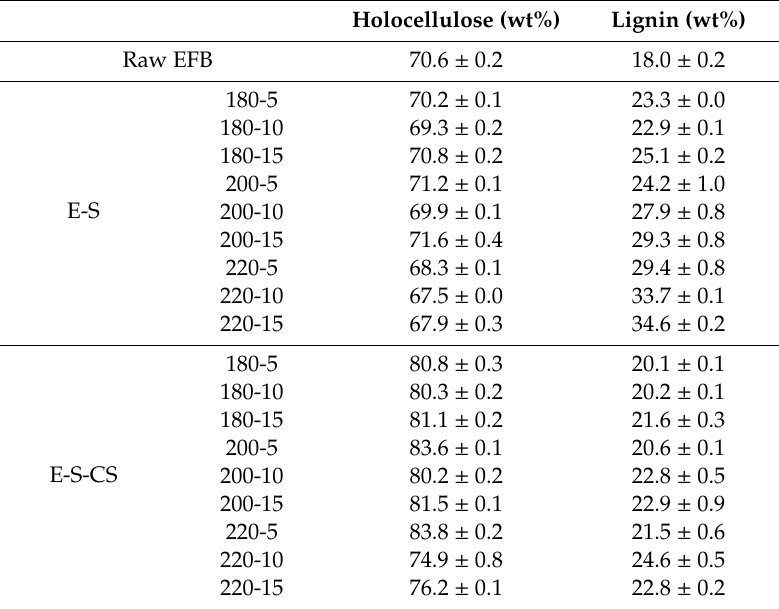
Table 2. Component analysis of pretreated EFB solid fractions under di ff erent temperatures and residence